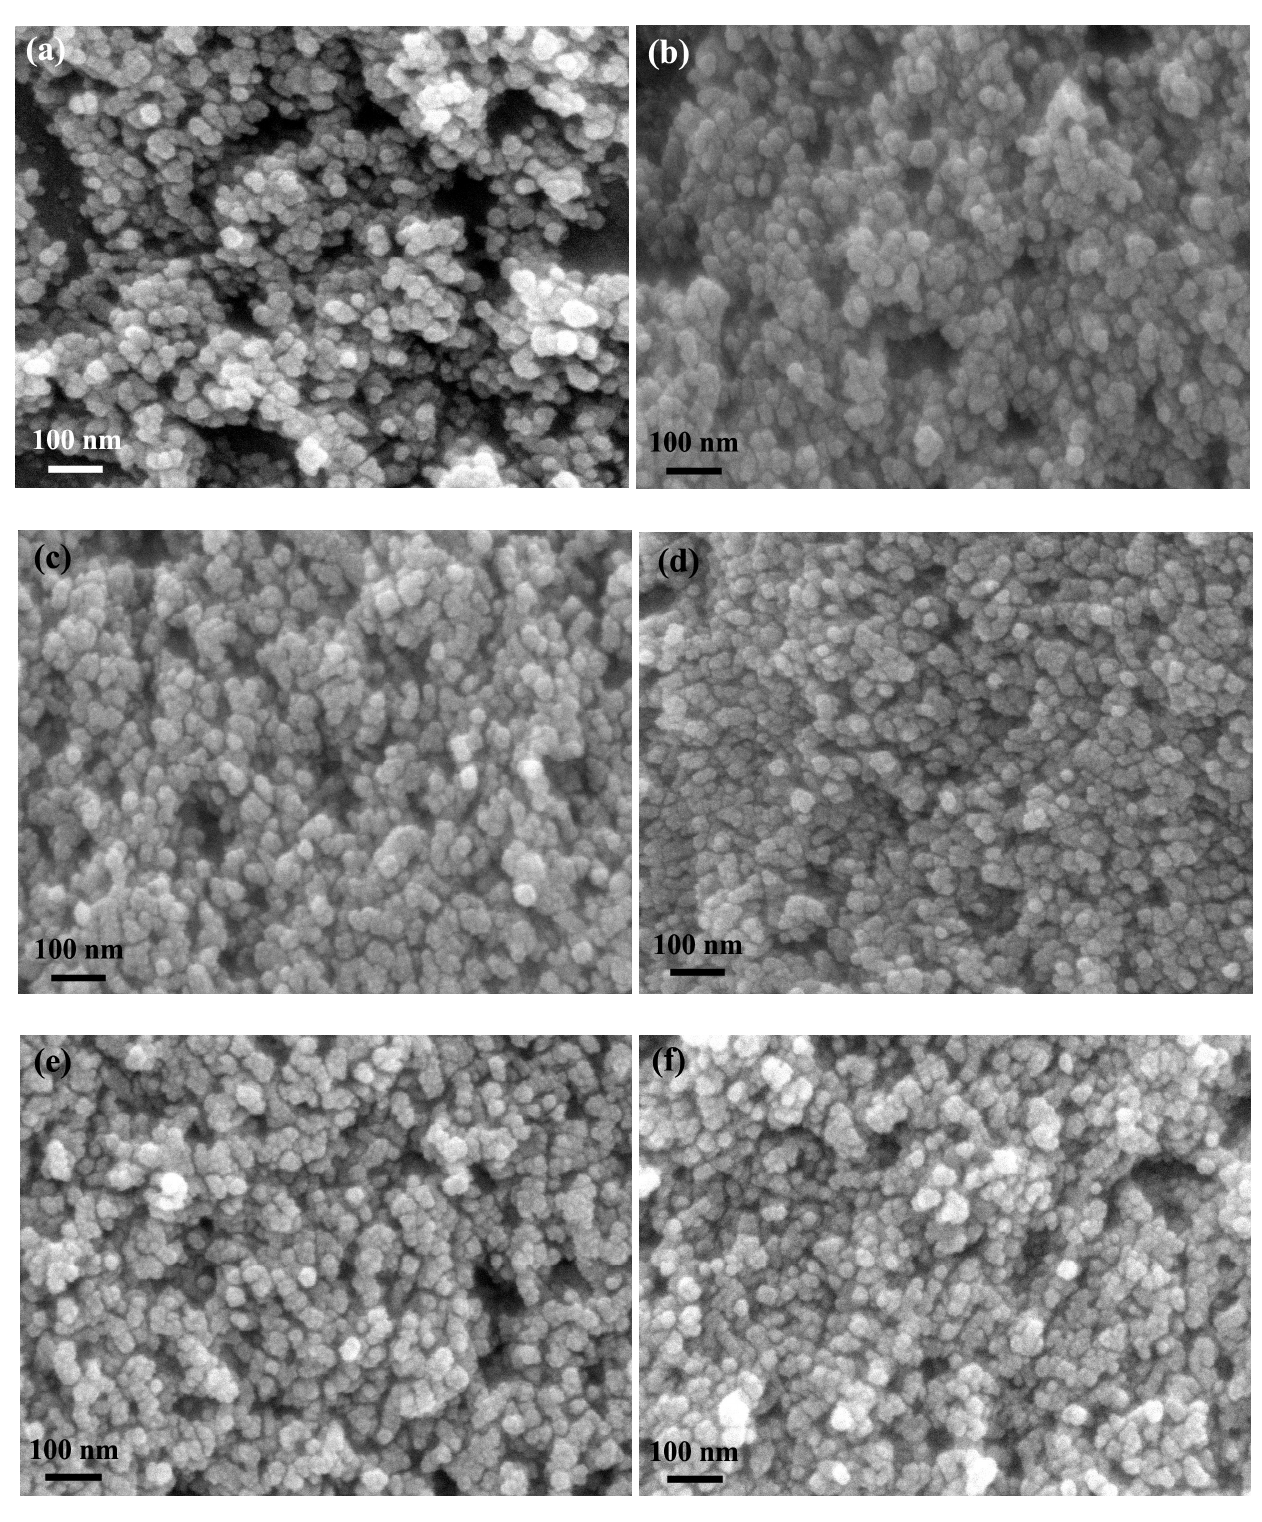
Figure 6. SEM images of highly crystalline flame-made (5/5) (a) pure ZnO, (b) 1 mol%, (c) 2 mol%, (d) 3 mol%, (e) 4 mol%, and (f) 5 mol% Pd/ZnO